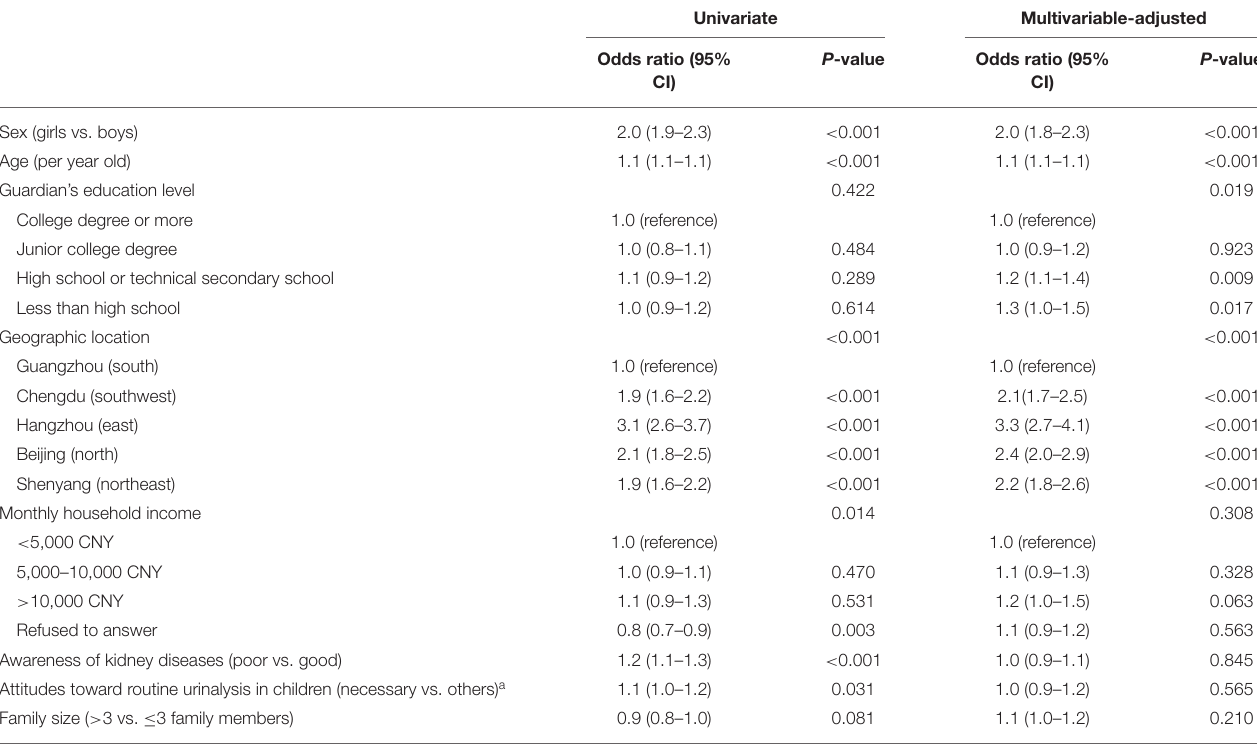
TABLE 3 | Factors associated with abnormal urinalysis in